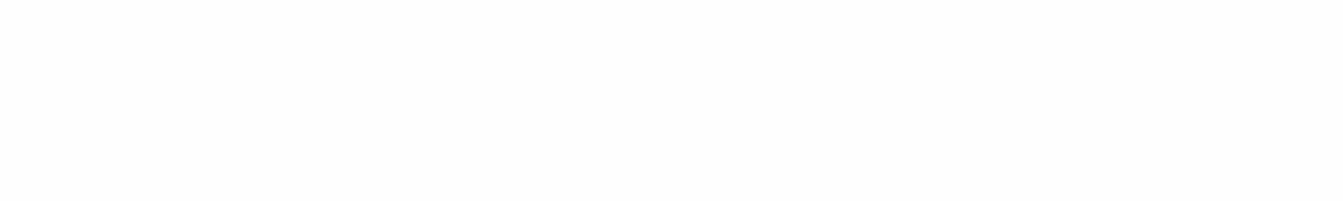
FIGURE 5 Bifurcation diagram for free model with cubic